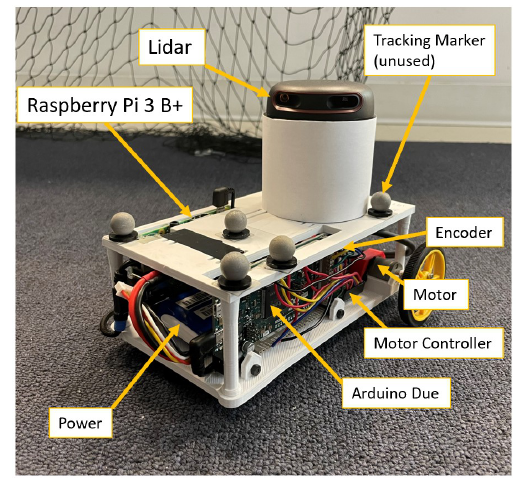
Figure 10. Overview of a mobile robot used for